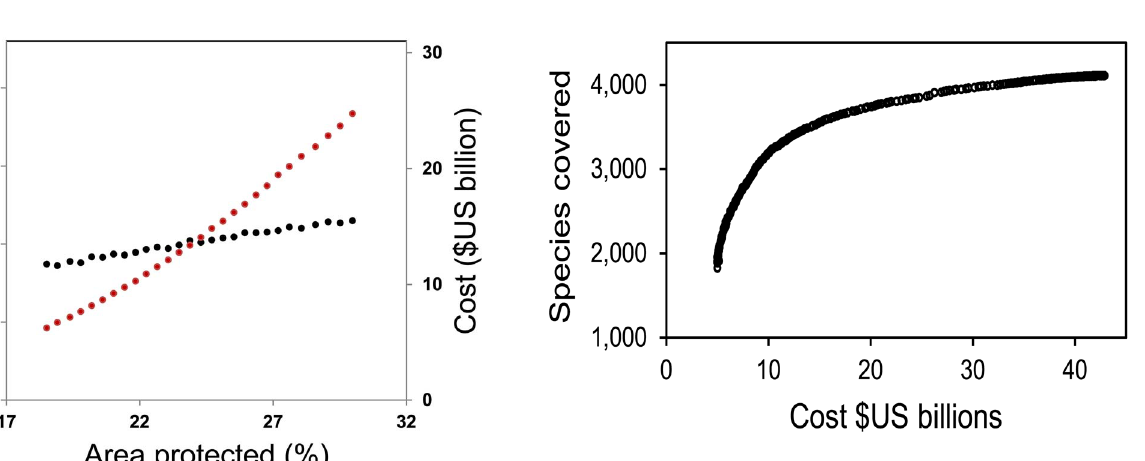
Figure 3. Efficiency frontier between the cost of establishing additional protected areas to achieve 17% coverage and the number of species covered. The y -axis presents the proportion of each species adequacy target that is met within protected areas, summed across all species, and is not directly comparable to that of the other figures, which only count species whose protected area coverage meets or exceeds their target.